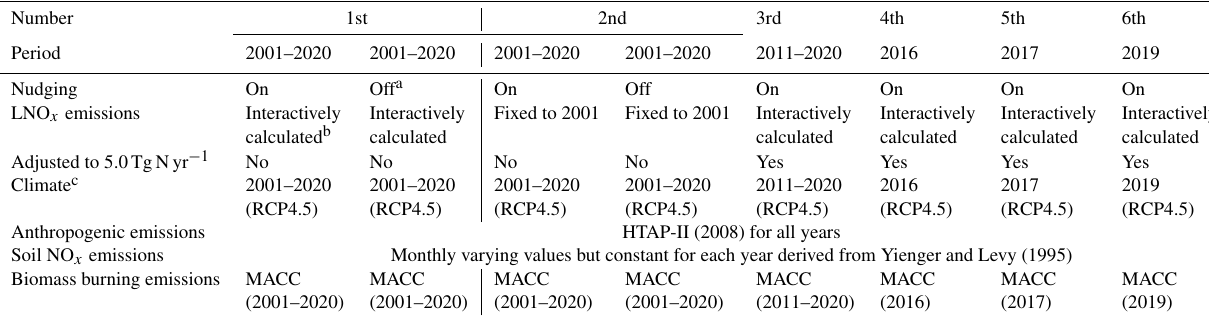
Table 2. All experiments in this study.